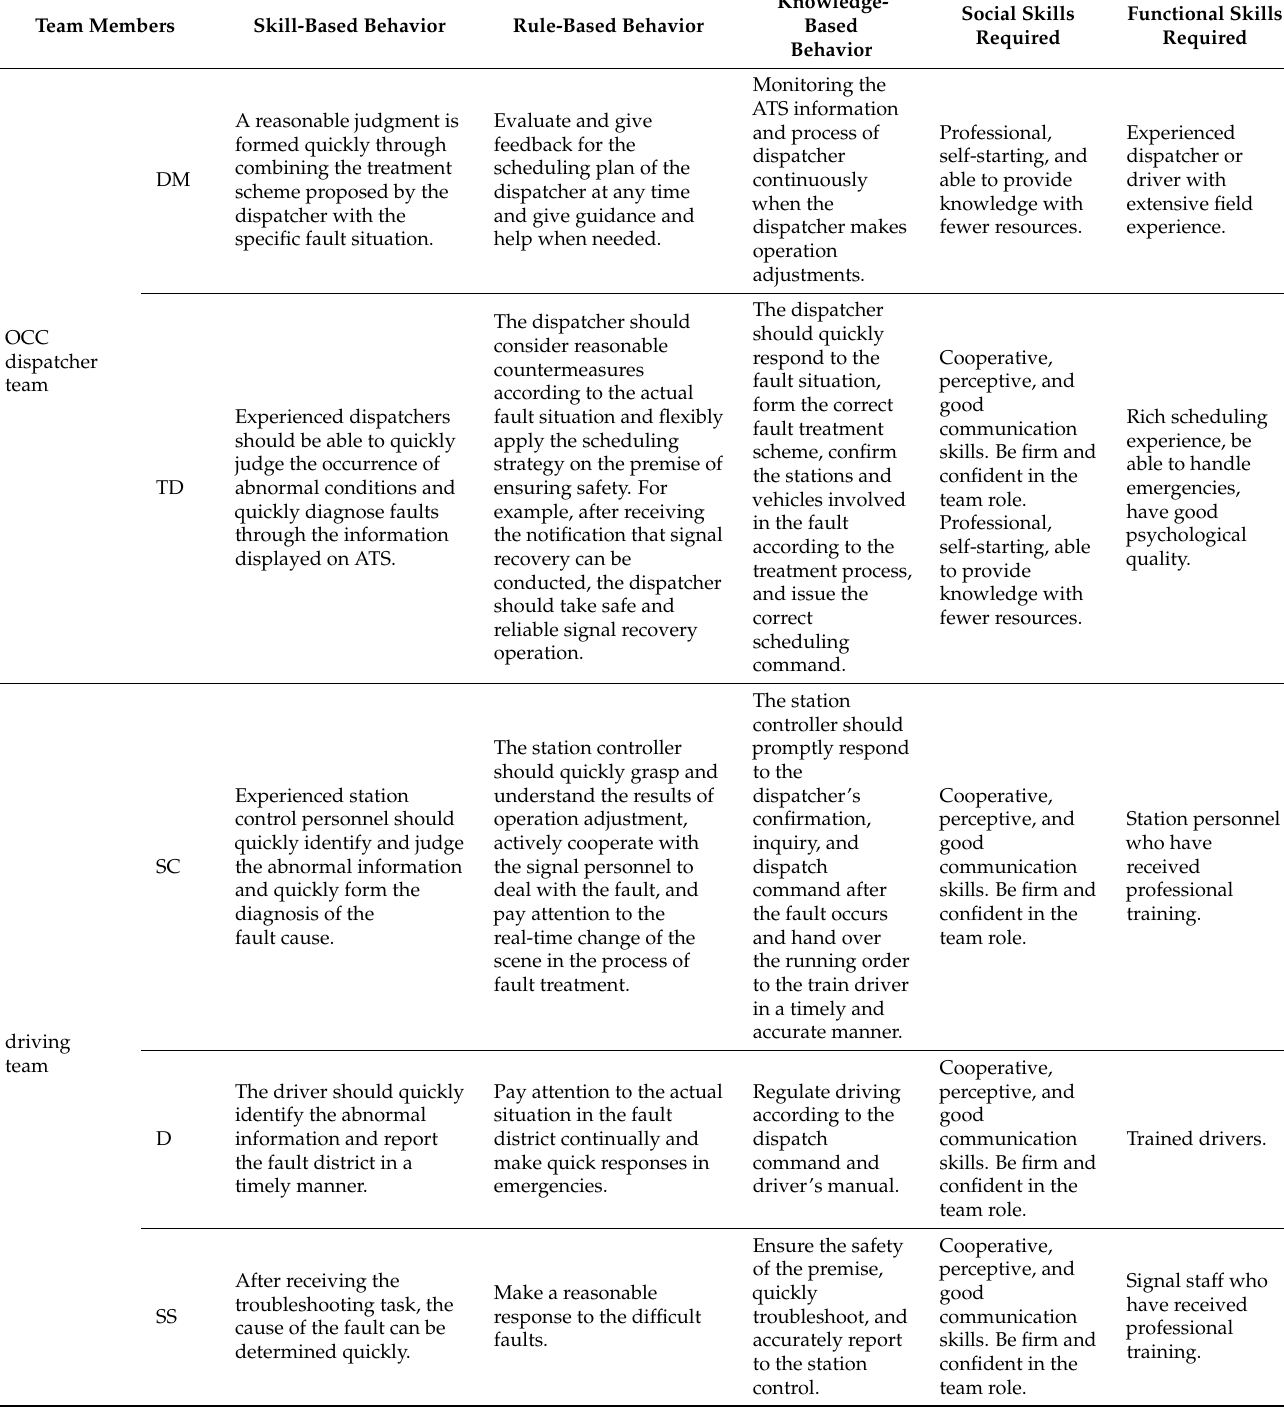
Table 3. Team worker competencies